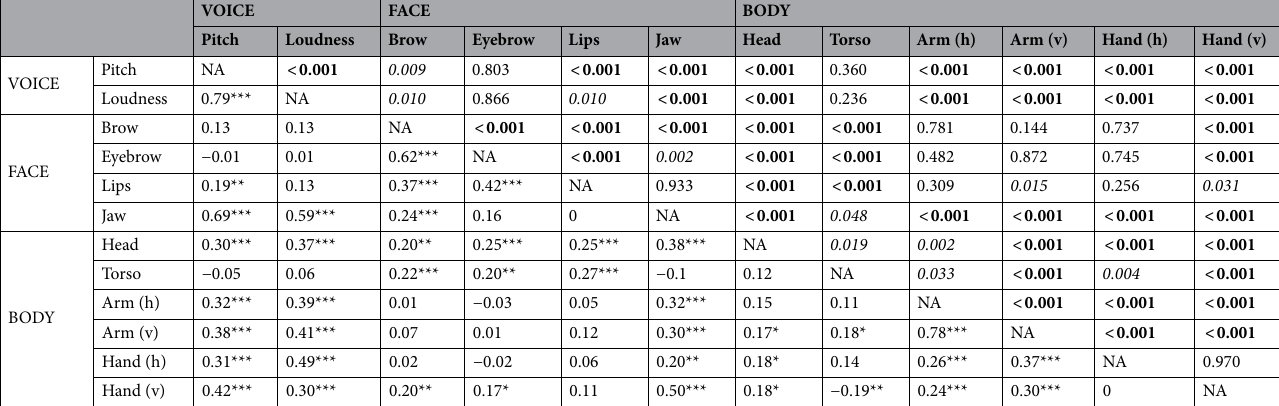
Table 3. Cross-modal correlations. Summary of the Pearson product-moment correlations and their significance for each modality: voice (pitch and loudness), face (brow, eyebrow, lips, and jaw), and body (head, torso, horizontal arm, vertical arm, horizontal hand, and vertical hand). The lower triangle contains Pearson r values, whereas the upper triangle contains uncorrected p values. For the upper triangle, p values that failed to reach significance after Bonferroni correction are in italics . P values that retained significance after Bonferroni corrections are in bold . For the lower triangle, * p CORR < .05, ** p CORR < .01, *** p CORR < .001, where “CORR” reflects the adjusted alpha value after Bonferroni correction for the 53 analyzed intermodal correlations, which are a subset of the 66 correlations shown in the table.